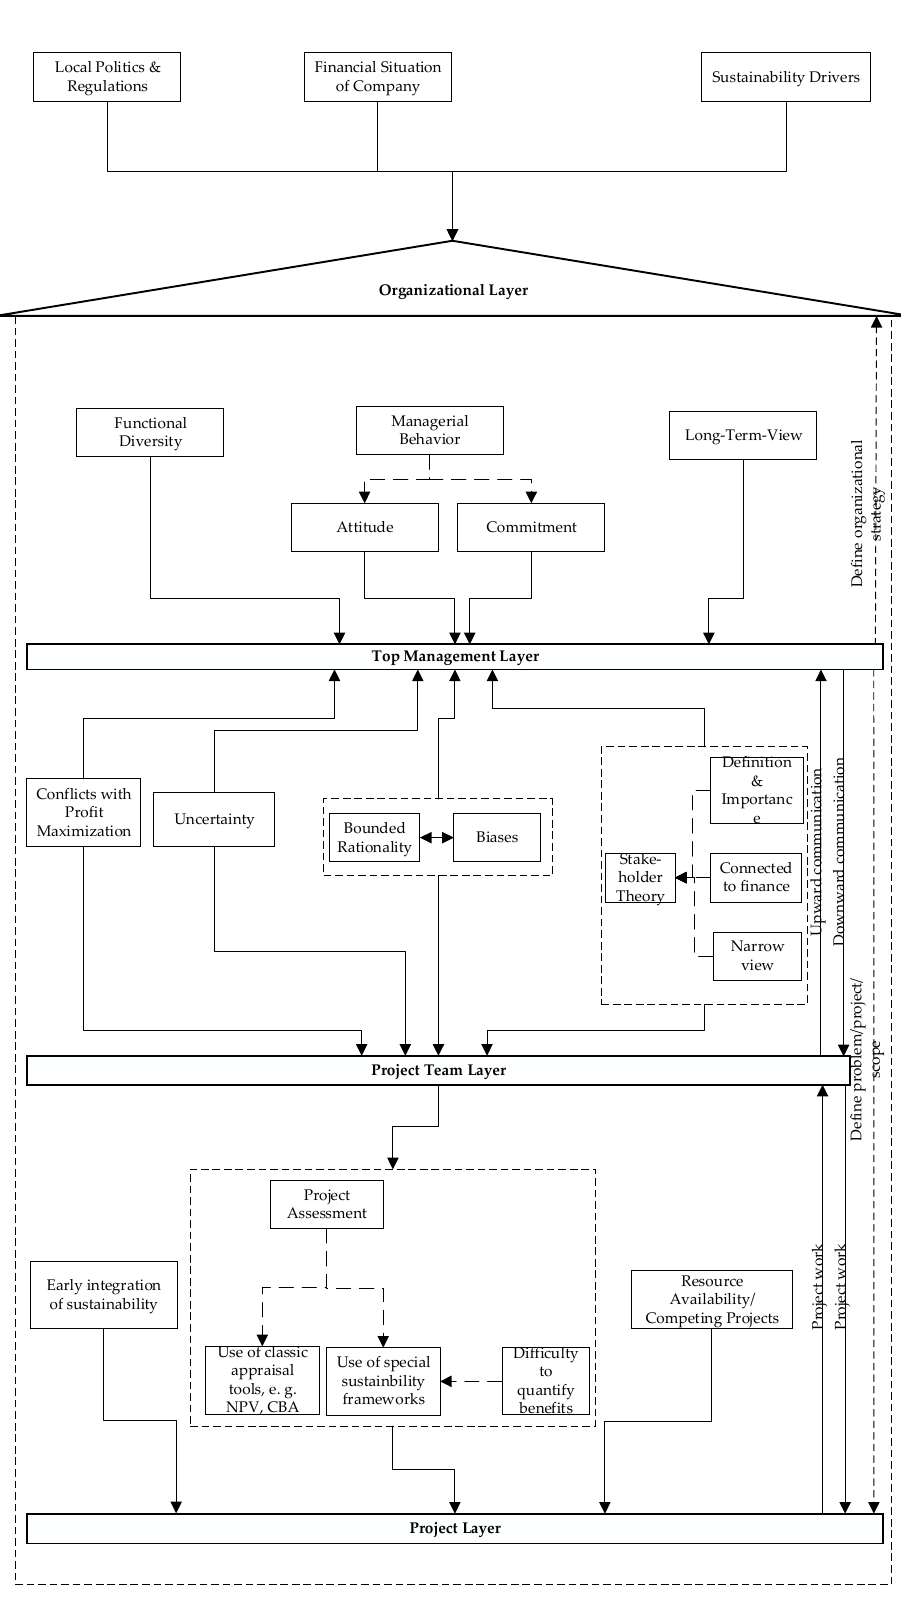
Figure 2. Framework model for the main influential factors on CS in organizations. The communication flow on the right side of the framework is for demonstration purposes only. Communication flow is of course much more complex. However, while TMT often determine